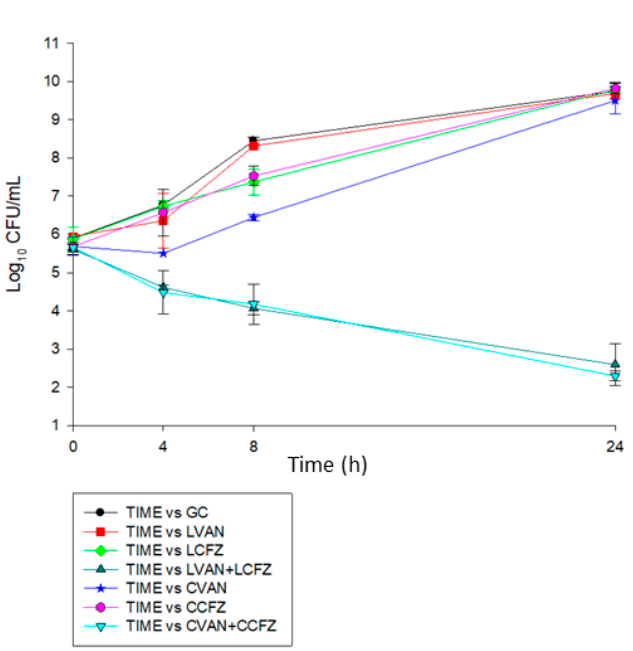
Figure 5. Time kill assay for methicillin-resistant Staphylococcus aureus (MRSA) 494 strain.